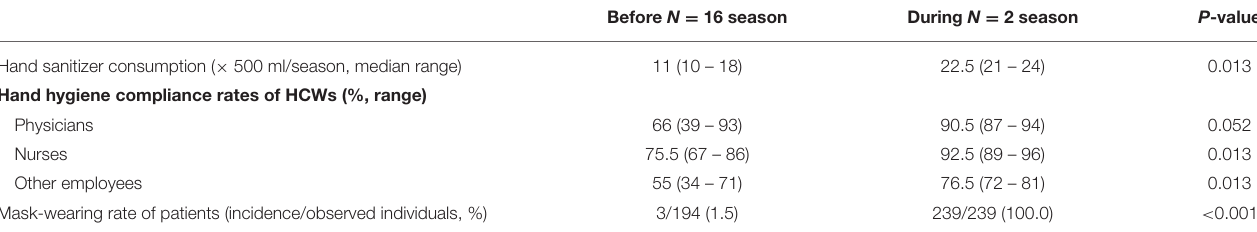
TABLE 2 | Adherence to infection prevention regulation of patients, caregivers, and HCWs in hemodialysis unit before and during mitigative confrontation of the COVID-19 pandemic.